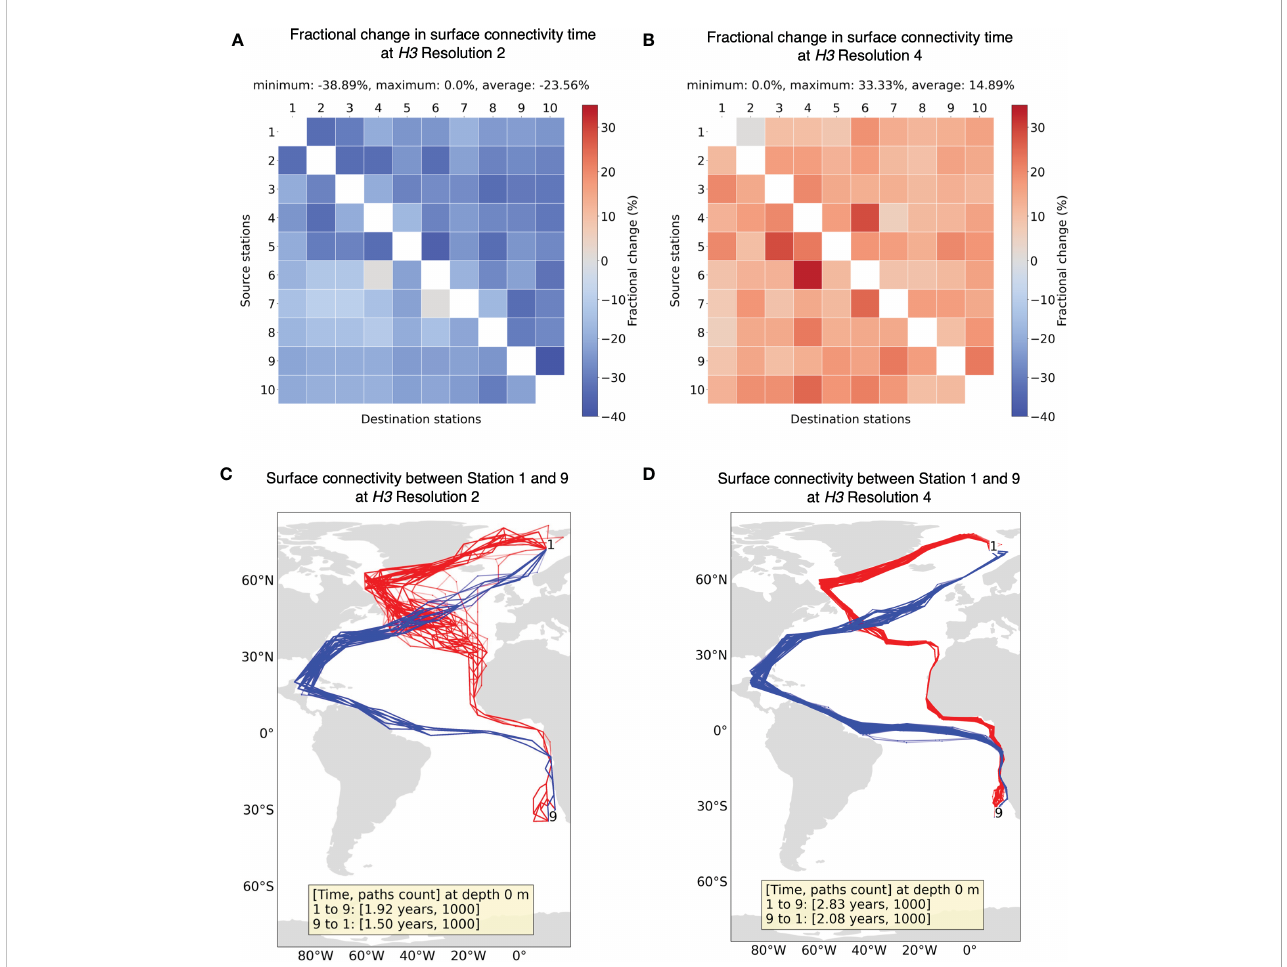
FIGURE 7 Fractional change in minimum connectivity time at the surface between all sample stations for (A) H3 resolution 2 and (B) H3 resolution 4 compared to the non-constrained surface connectivity time (Figure 4A). The stations are in the ascending order of their latitudes. Example of connectivity paths and time between Station 1 and 9 for (C) H3 resolution 2 and (D) H3 resolution